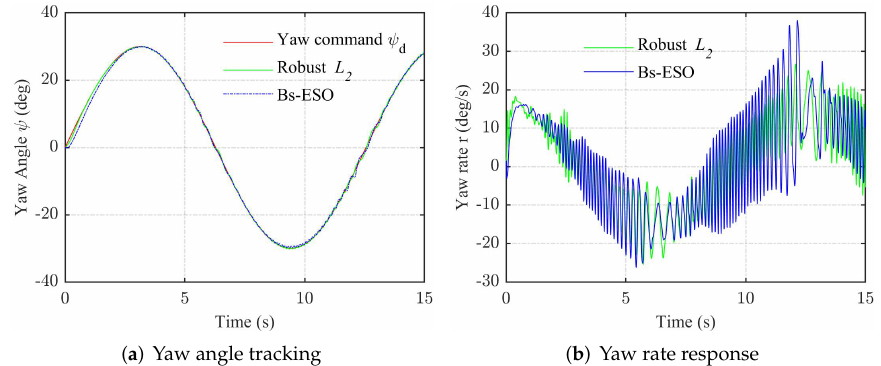
Figure 7. Sine tracking performance in the presence of a harmonic motor